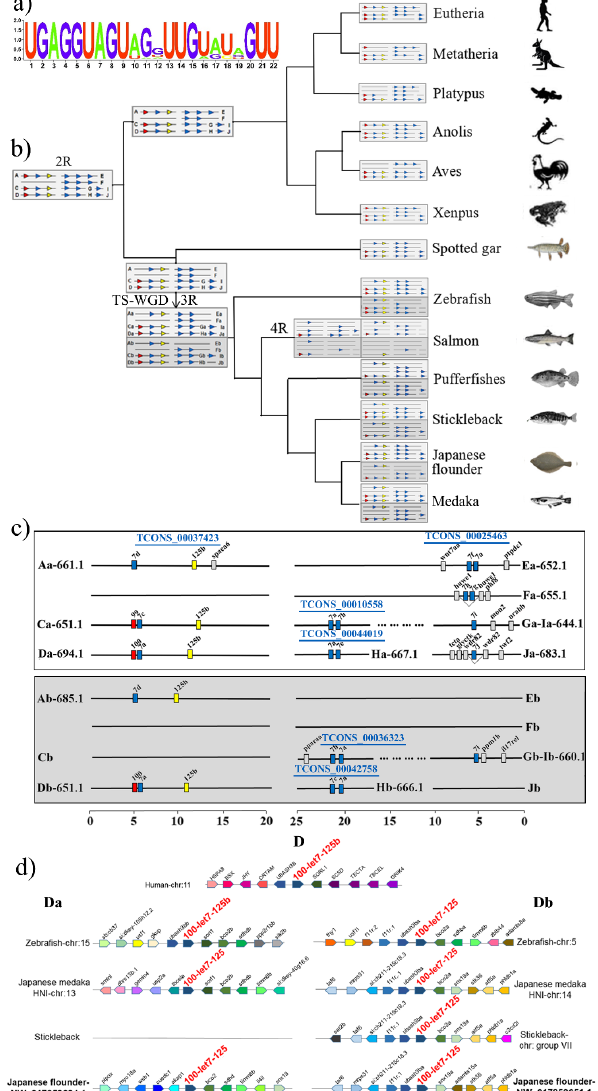
Figure 5. Characterization of let-7 clusters in P. olivaceus genome. ( a ) Consensus sequence of the 20 P. olivaceus let-7 members with seed sequence “GAGGUAG”; ( b ) Putative evolutionary trajectory of the let-7 / miR-125b clusters across vertebrates (modified and referenced from [48]). Red triangles represent miR-100 , yellow triangles represent miR-125b , while let-7 sequences are shown as blue triangles. 1R/2R indicate two rounds of whole genome duplications, while TS-WGD represents the additional teleost- specific genome duplication. The duplicate clusters in teleost are highlighted as two boxes; ( c ) Detailed annotation of P. olivaceus let-7 clusters with six putative lncRNA precursors; ( d ) Synteny for let-7 cluster D. The pentagon’s direction shows the gene direction compared with the reference